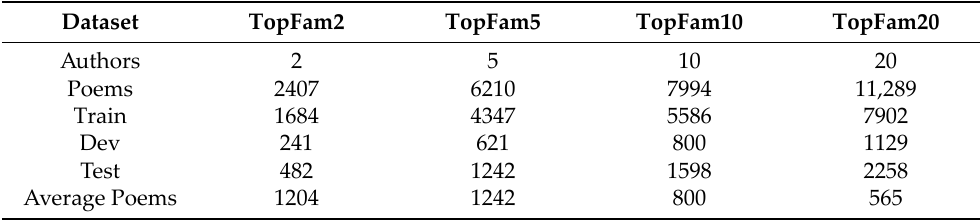
Table 2. Dataset statistics.